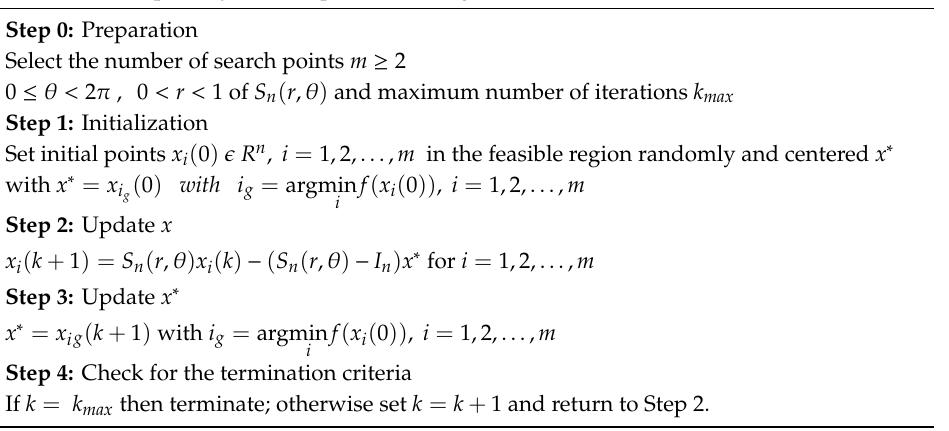
Algorithm 1: Spiral dynamics optimization algorithm